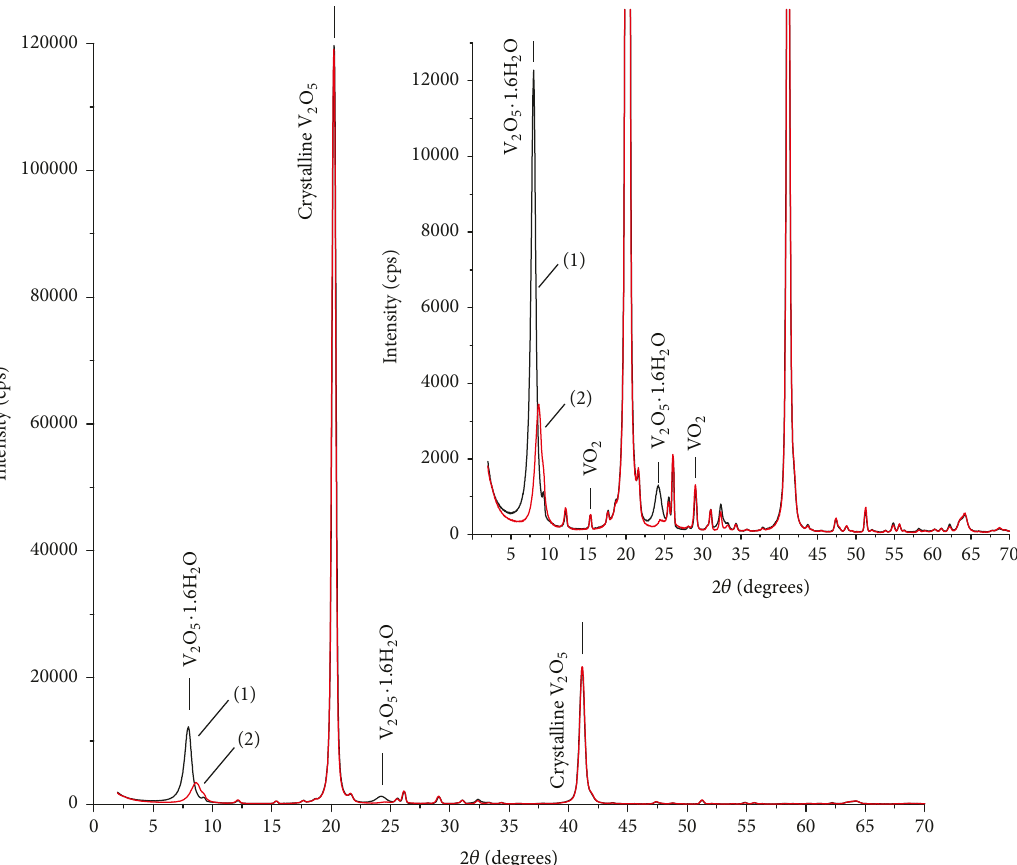
Figure 7: XRD patterns of V 2 O 5 ⋅ n H 2 O film annealed at 400 ∘ b (1) and that same film hydrogenated after annealing (2) . For curve (1) , the peaks corresponding to crystalline V 2 O 5 coincide with the peaks of curve (2) .